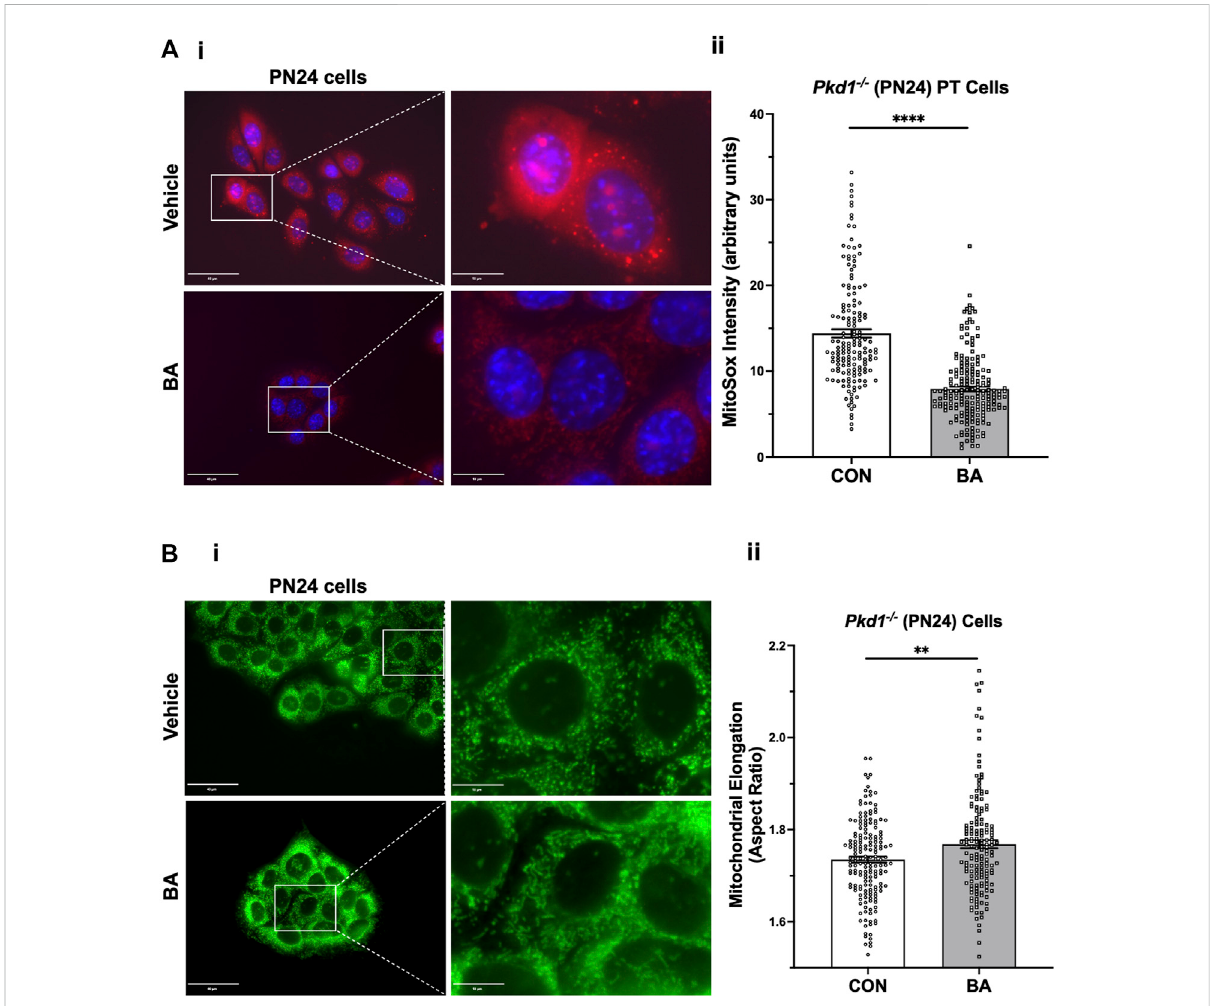
Bempedoic acid (BA) inhibits mitochondrial superoxide production and promotes mitochondrial elongation in Pkd1 − / − cells. (A) To analyze the effect of BA on mitochondrial superoxide production, PT-derived Pkd1 − / − (PN24) cells were stained with MitoSOX ™ Red mitochondrial superoxide indicator (red) and Hoechst 33342 nuclear stain ( blue ). i Representative epi fl uorescence micrograph images are shown of PN24 cells in the absence (top)orpresence(bottom)ofBAtreatment(100 µM)for24 h.Leftpanelscalebars=40 µm.Rightpanelsshowenlargementofinsetareasinthe leftpanels(right panelscalebars=10 µm).iiSummary datareveal thatBAtreatmentdramaticallydecreasedmitochondrial superoxideproductionin PN24 cells ( n = 159 – 188 cells analyzed from four biological replicates; **** p < 0.0001). (B) BA treatment signi fi cantly increased mitochondrial elongation of Pkd1 − / − PN24 cells. i Representative images of MitoTracker Green-stained cells in the absence (top) or presence (bottom) of BA treatment (100 µM) for 24 h. Left panel scale bars = 40 µm. Right panels show enlargement of inset areas in the left panels (right panel scale bars